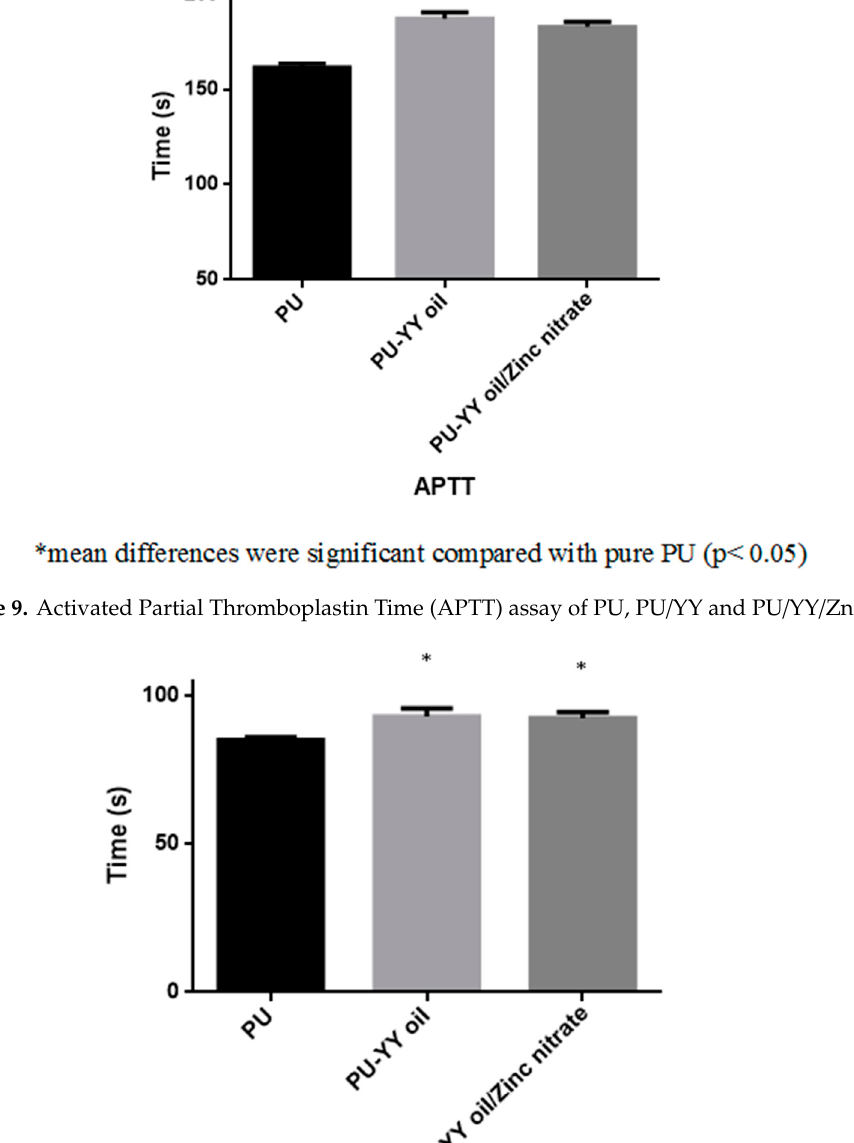
Figure 10. Prothrombin Time (PT) assay of PU, PU/YY and PU/YY/ZnNO 3.